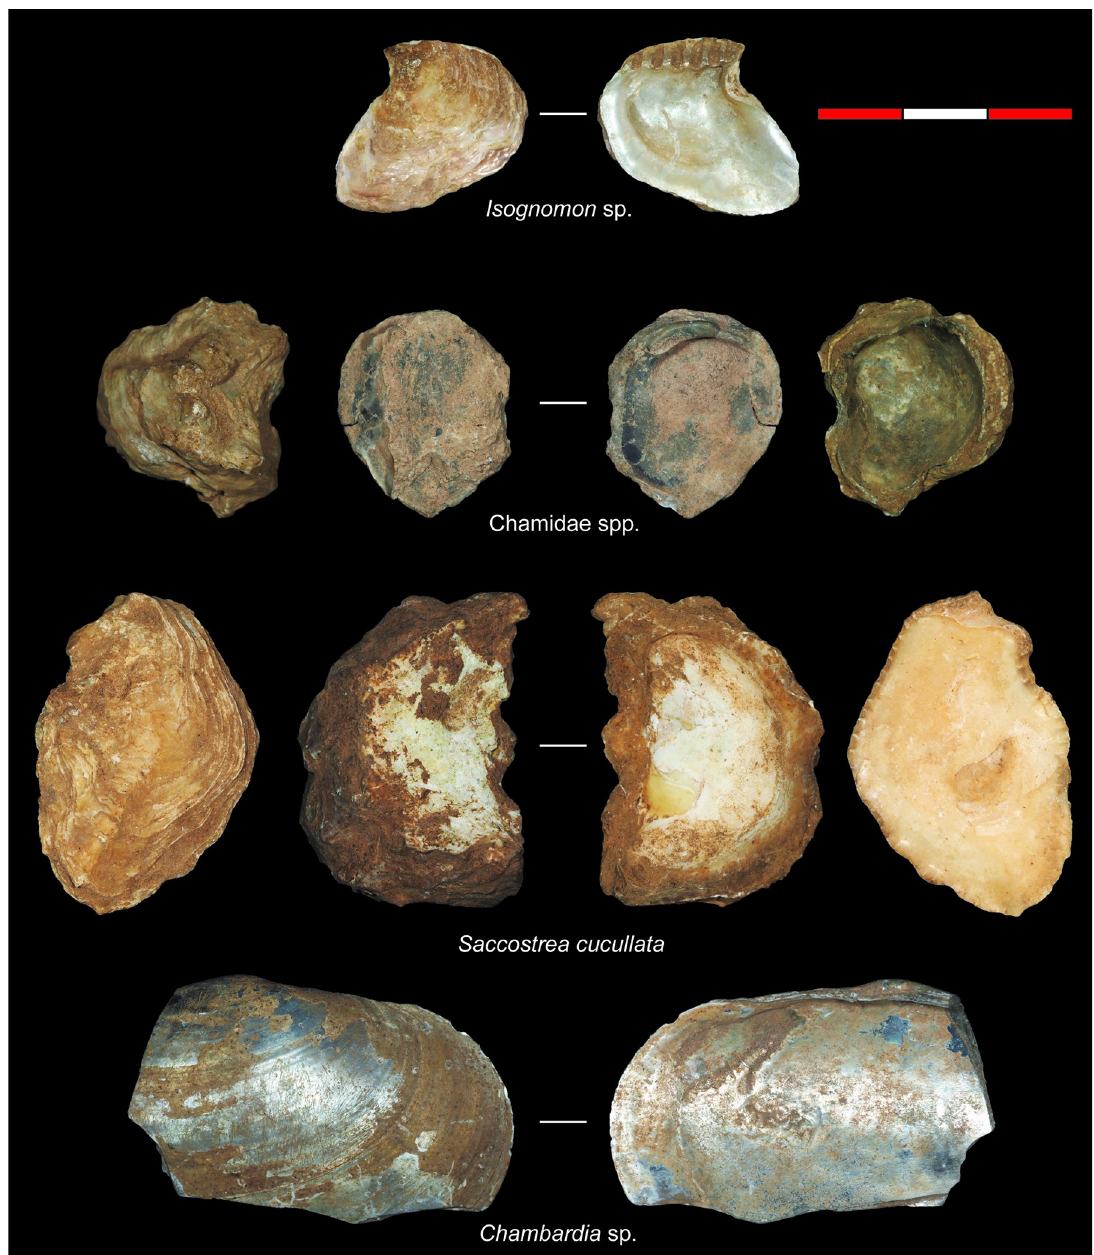
Fig 5. Examples of the marine and freshwater bivalve taxa recovered from